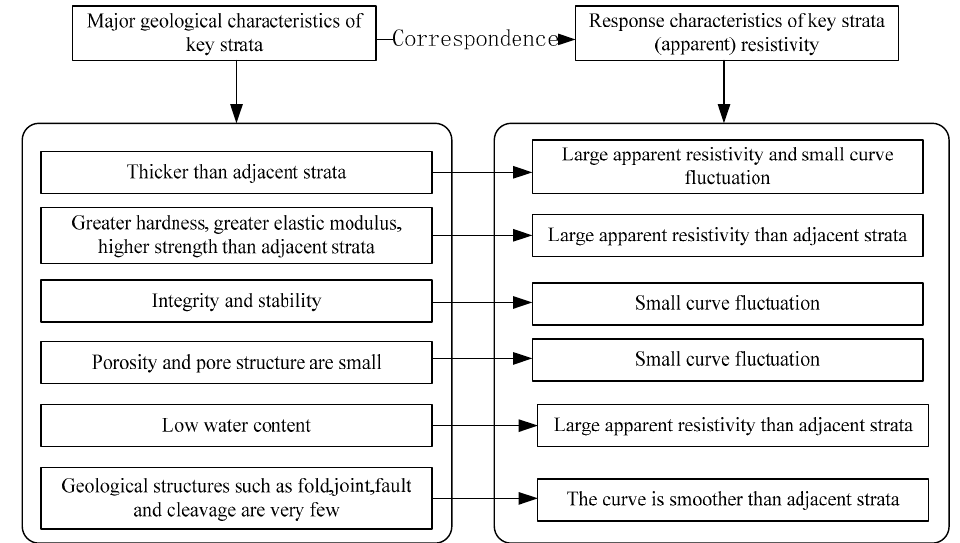
Figure 3. Relationship between KS characteristics and its apparent resistivity (AR) response.